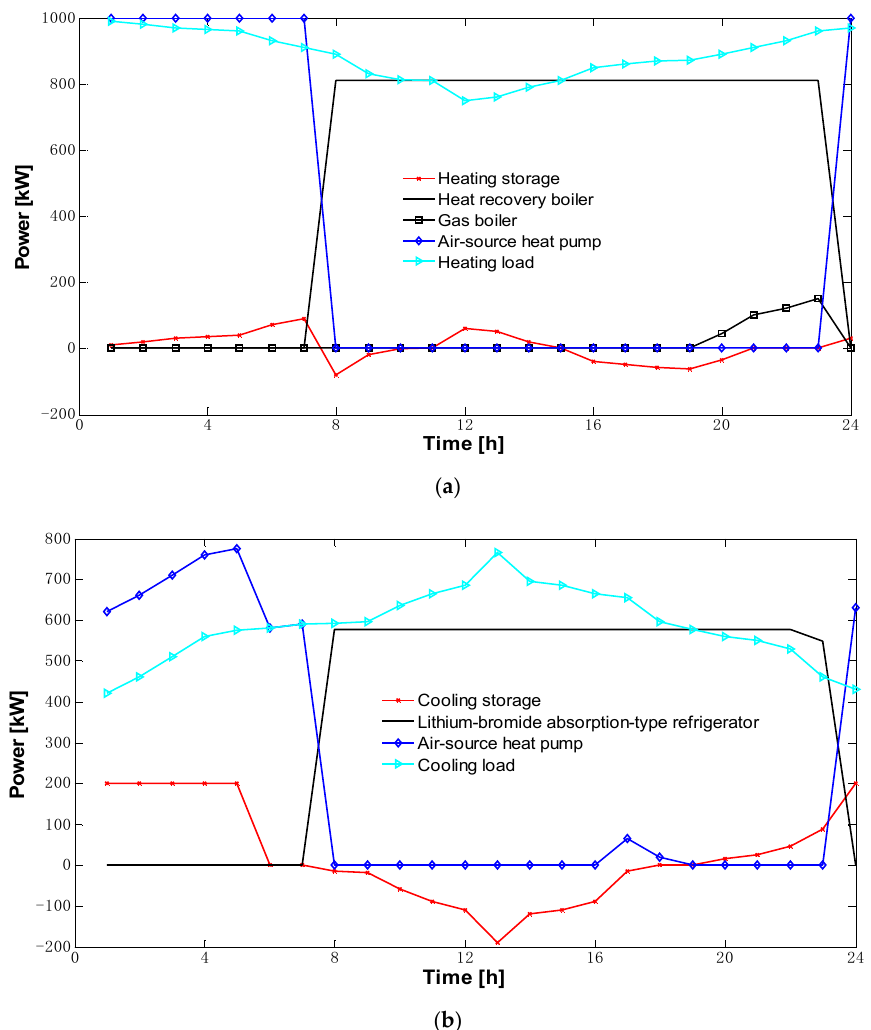
Figure 9. The heating load balance curves of a typical day in winter ( a ) and the cooling load balance curves of a typical day in summer ( b ) under day-ahead optimal dispatching mode.